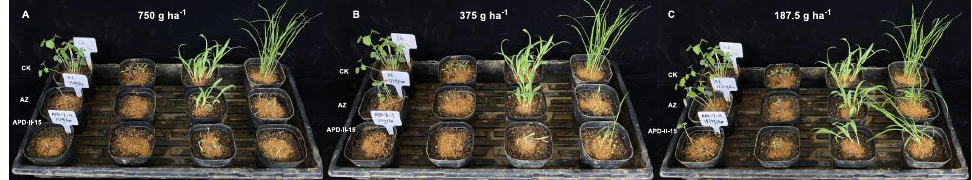
Figure 6. Photographs illustrating loss of plant weight at a different dosage of compound APD-II-15 and atrazine under pre-emergence conditions after treatment at 14 days; ( A ) at a dosage of 750 g ha − 1 ; ( B ) at a dosage of 375 g ha − 1 ; ( C ) at a dosage of 187.5 g ha − 1 . The top row of each pallet is CK, the middle row is the plant treated by AZ, and the bottom row is the plant treated by APD-II-15. In each pallet, from left to right: Abutilon theophrasti Medicus (AM), Amaranthus retroflexus L. (AR), Echinochloa crus-galli (EC), Digitaria sanguinalis (L.) Scop. (DS). It is noteworthy that introducing a hydroxyl at the terminal of the alkyl chain signif- icantly improved the herbicidal activity (for example, APD-II-15 (R 2 = 2-hydroxyethyl, sum inhibition = 270.9%) > APD-II-1 (R 2 = Et, sum inhibition = 170.9%) and APD-II-16 (R 2 = 1-hydroxypropan-2-yl, sum inhibition = 199.7%) > APD-II-7 (R 2 = i-propyl,